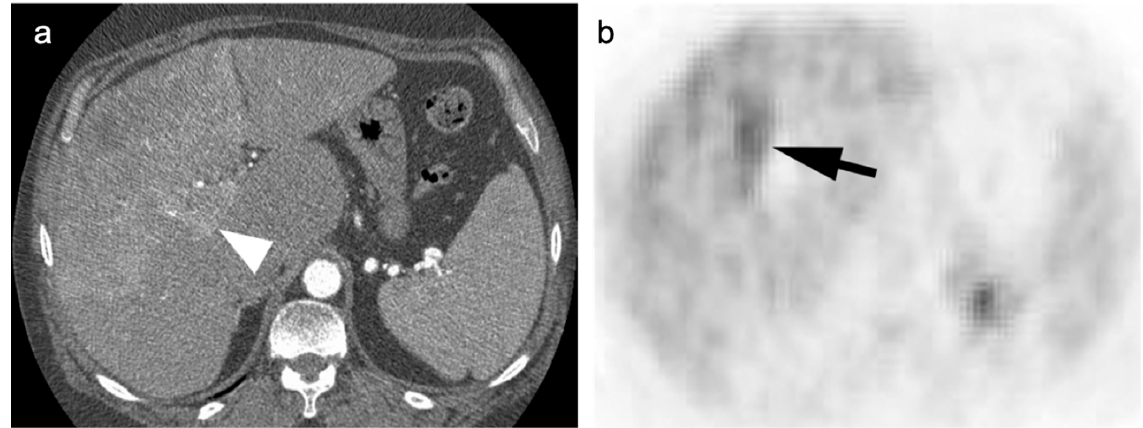
Figure 15. ( a ) A biopsy-proven well-differentiated HCC shows diffuse arterial enhancement on contrast-enhanced CT (white arrowhead); ( b ) On axial FDG PET, this mass is largely isometabolic to the liver, although a central more focally hypermetabolic regions may indicate a region of more poorly differentiated tumor (black arrow).